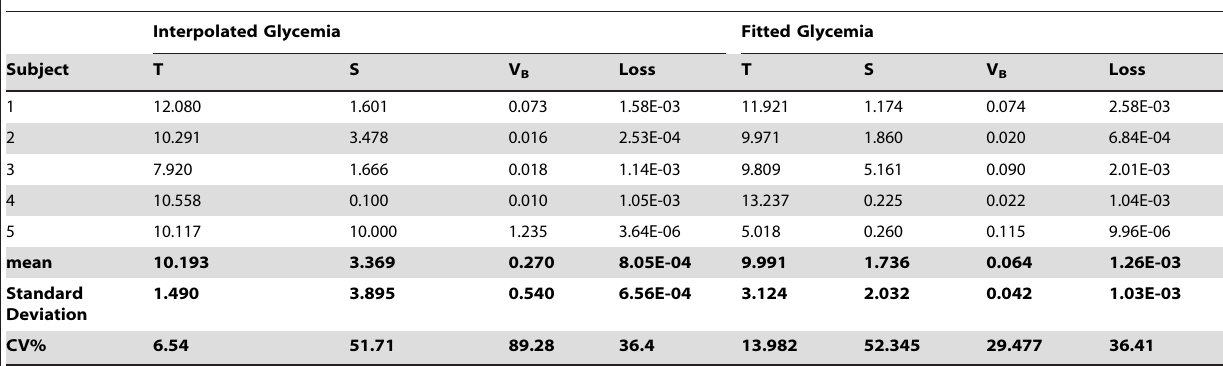
Table 5. Parameter estimates for the RTH model, free Slope.